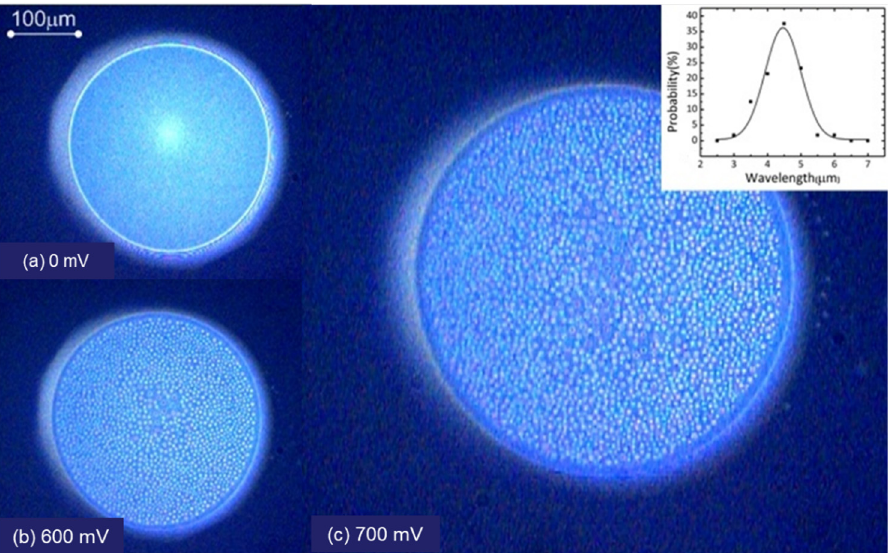
Figure 2. ( a ) Film at equilibrium, U = 0 mV; ( b ) instabilities that appeared on the plane of the film when an electric potential was applied, U = 600 mV; and ( c ) instabilities at U = 700 mV, the inset shows the nearest-neighbor distribution of the white spots.